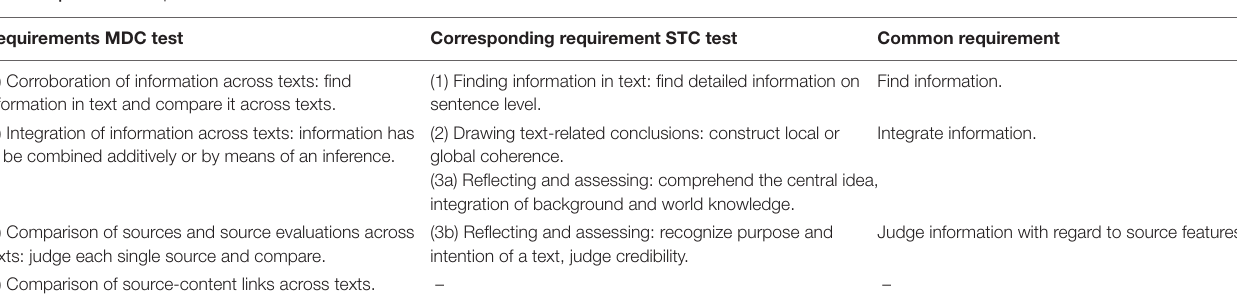
TABLE 3 | Common requirements of the MDC and STC test. Requirements MDC